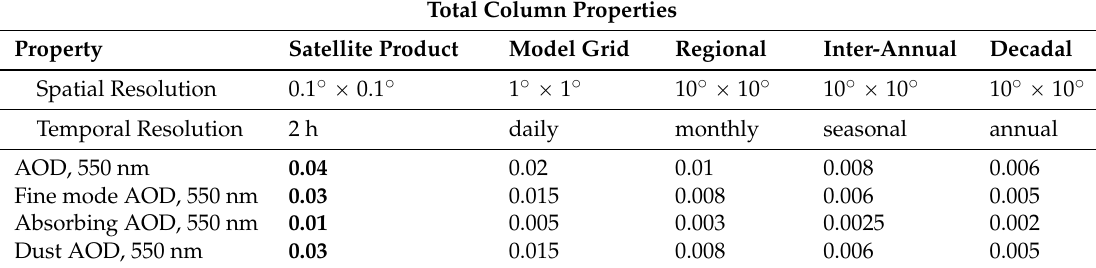
Table 2. Total column Aerosol Optical Depth (AOD) accuracy requirements as function of spatial/ temporal